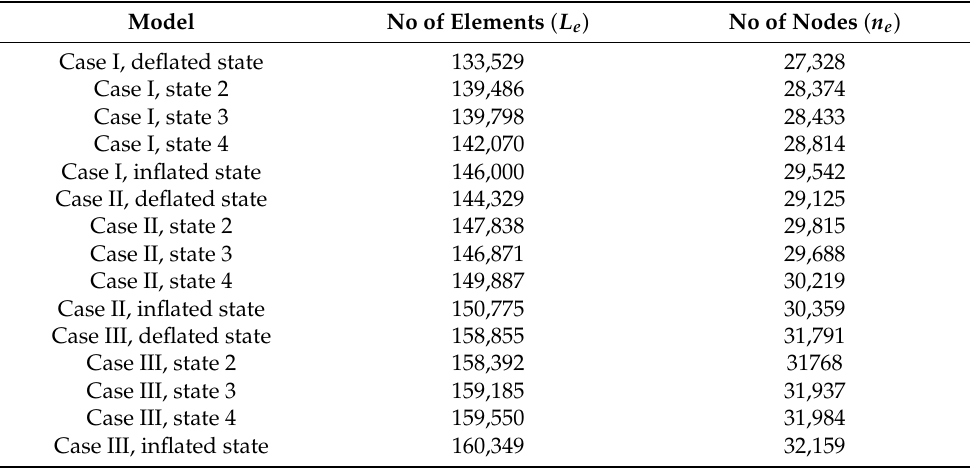
Figure 5. Cross-sectional boundary and lung shape changes from the end-expiration to the end- inspiration states. The extracted shapes were used to create extruded 3 D models using NETGEN. Table 2. Number of tetrahedral elements and nodes per each 3 D thoracic F.E.